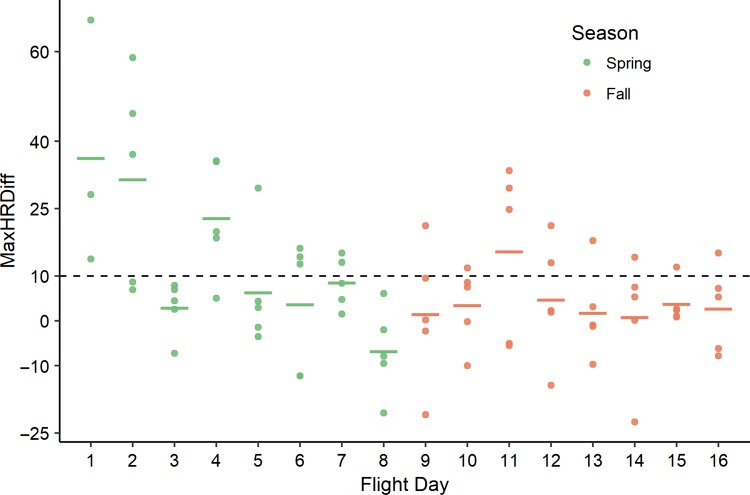
Differences between pre-flight baseline (95% upper CI of HR 30-min prior to first UAS flight of each day) and maximum HRs of five captive black bears (each point is a single bear; horizontal bars represent means of the bears) during exposure to the first UAS flight on each flight day (i.e. the flight eliciting the greatest response; see Fig. 2). We flew a quadcopter UAS 15 m over the bears’ enclosure 2 days per week, 4 weeks per season during spring and fall (16 flight-days). We considered habituation to have occurred when the mean of maximum elevations in HR remained below +10 bpm (dashed line). This occurred on flight day 5 (third week).